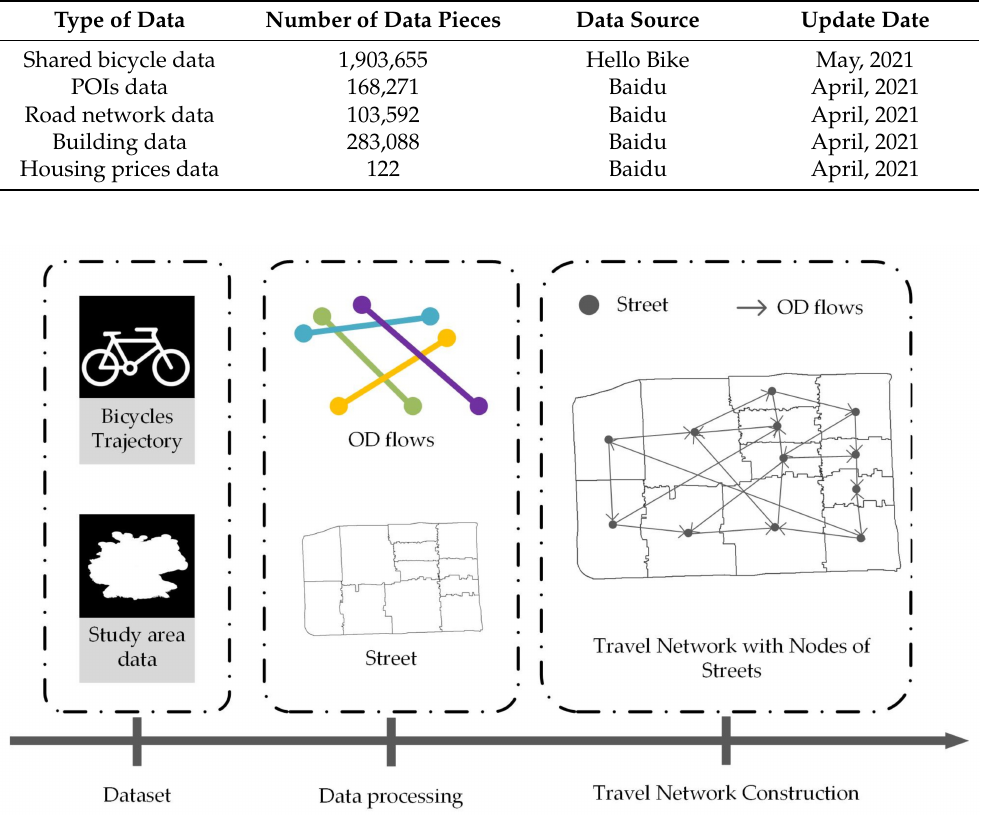
Figure 4. Travel network construction. The data used in this paper include shared bike trajectories and study areas. The OD flows are generated from the shared bicycle trajectory, and the streets in the study area are extracted as network nodes. The location of the start and end points of the OD stream are determined by the location of the block. A travel network is generated with streets as